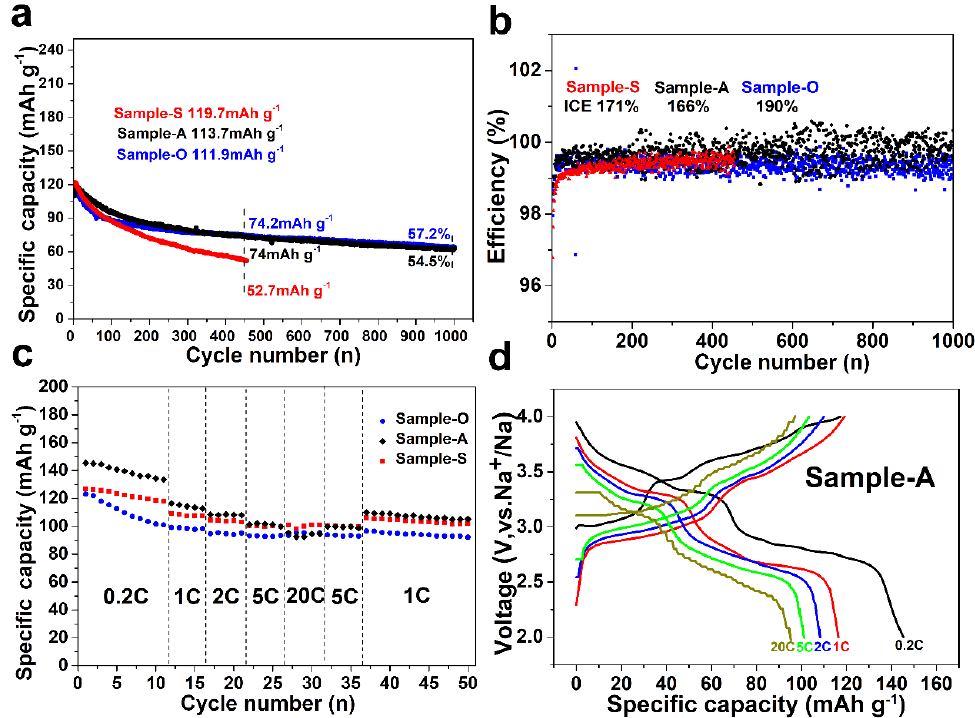
Figure 3. ( a ) Electrochemical cycle performance at 1 C, 1 C = 170 mA g − 1 . ( b ) Efficiency of each electrochemical cycle at 1 C, 1 C = 170 mA g − 1 . ( c ) Electrochemical rate performance from 0.2 C to 20 C, 1 C = 170 mA g − 1 . ( d ) Charge and discharge curves of Sample-A at various current densities.